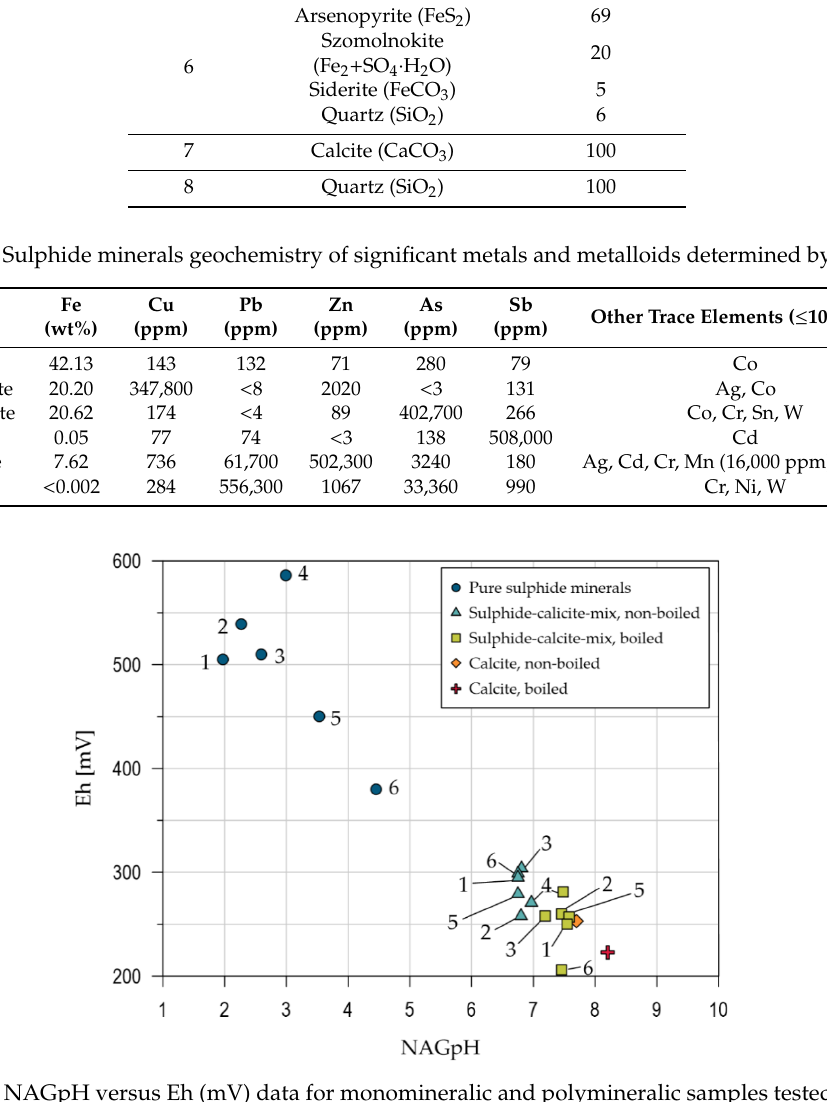
Table 2. Mineralogy of samples as determined by XRD.